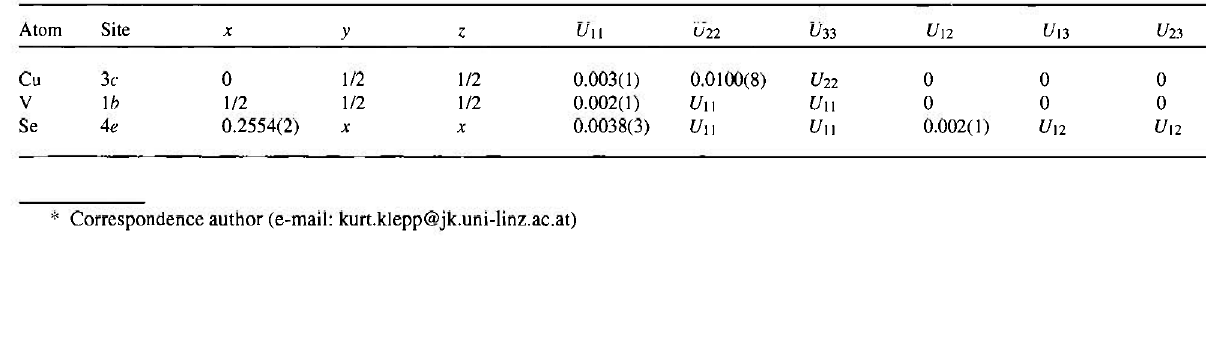
Table 2. Atomic coordinates and displacement parameters (in Ä 2 ).